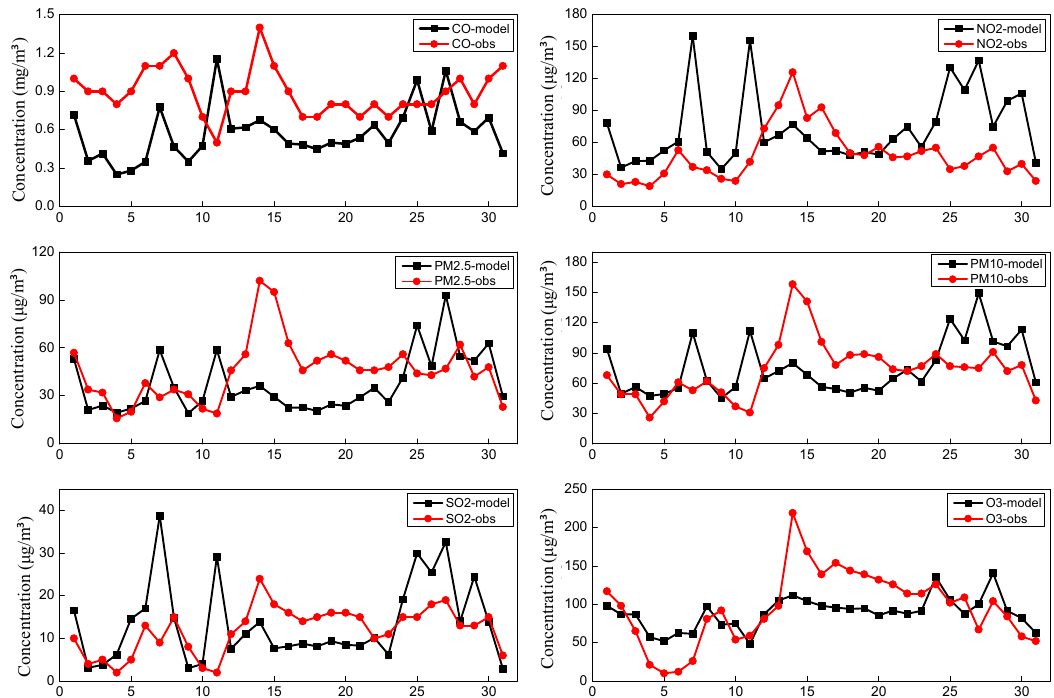
Figure 5. Comparisons of simulated and observed CO, NO 2 , PM 2.5 , PM 10 , SO 2 , and O 3. (Daily statistical data in October 2015 in Haizhu district; O 3 : daily 8-h maximum concentration; other pollutants: daily-averaged concentration).